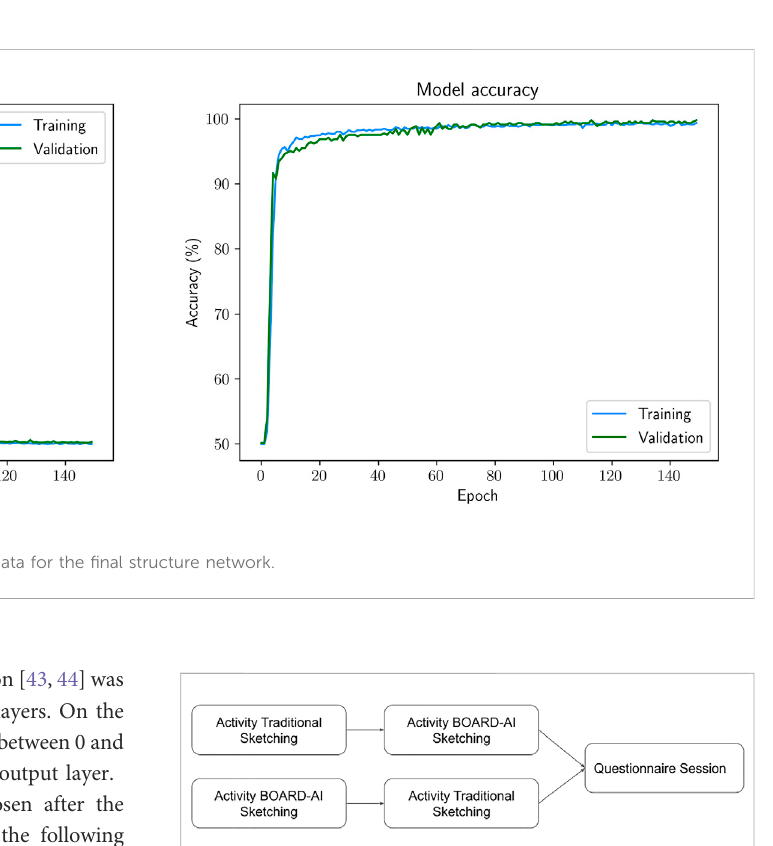
FIGURE 9 Exploratory Study Design and data gathering